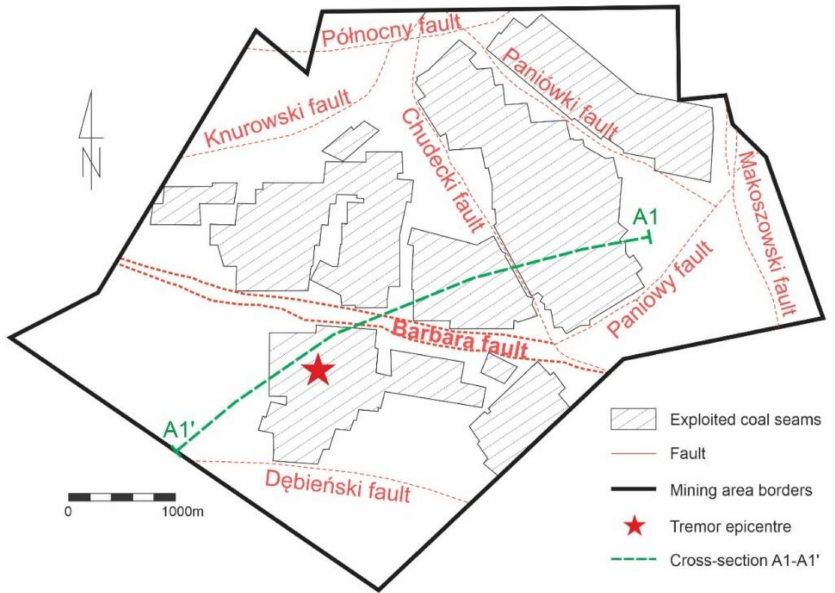
Figure 3. Sketch of the exploitation of coal seams on both sides of the Barbara fault